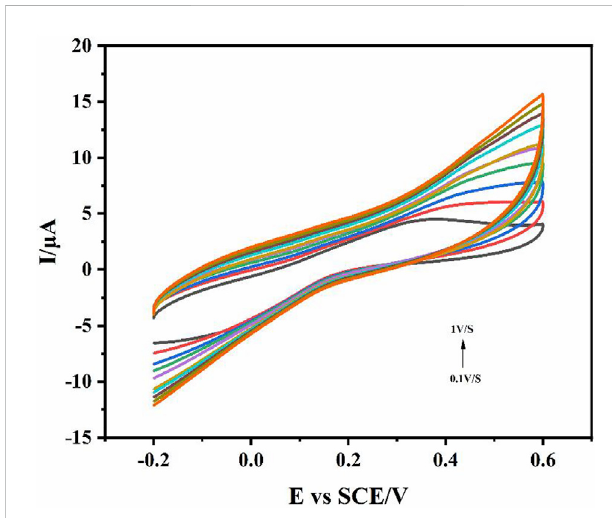
FIGURE 3 TheCVcurves ofdifferentscanningratesinthereactionsolutionof standard concentration of IL-6. Scan rate 0.1V/S-1V/S.